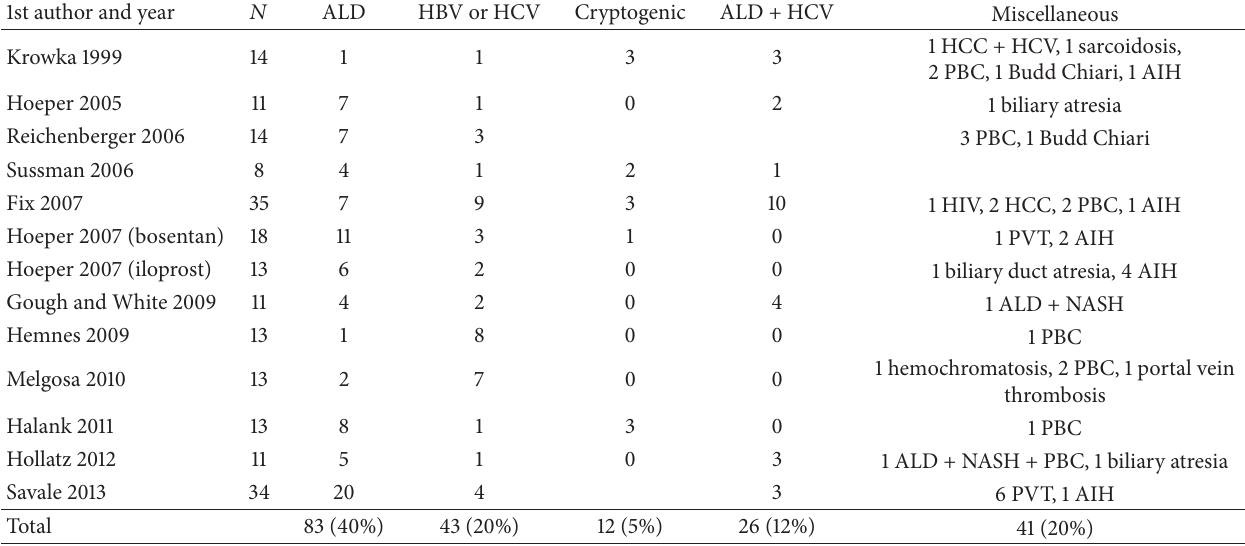
Table 1: Underlying causes of portal hypertension in the included studies [10–21].